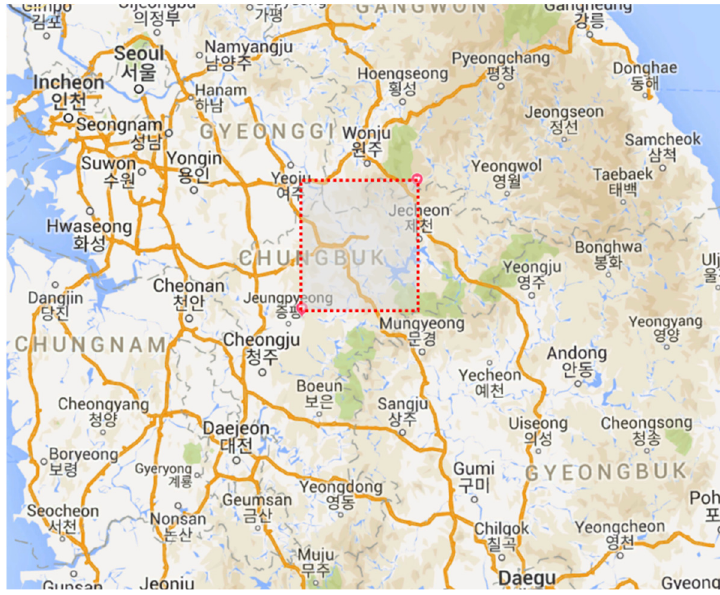
Figure 9. GPS coordinate area used for data generation.